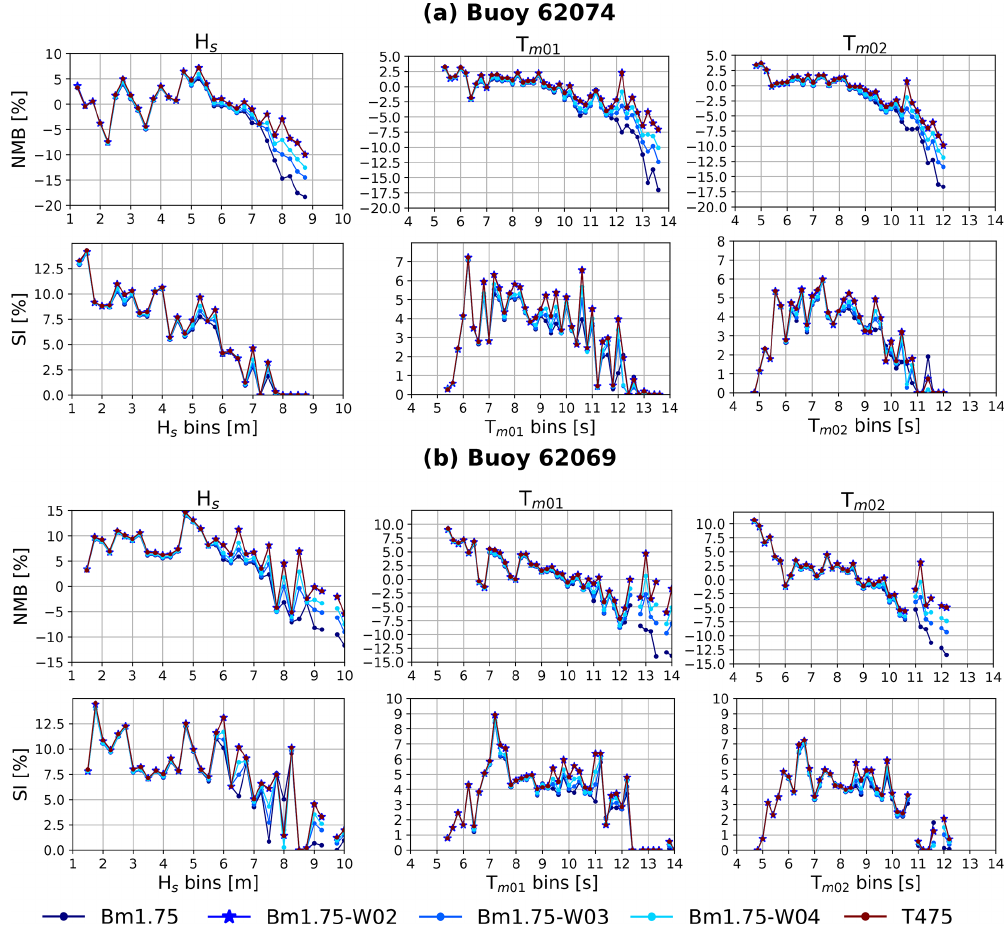
Figure 6. Bias (NMB) and scatter index (SI) for tests leading to T475 (Table 2). Results for January 2014. In (a) and (b) modeled results are compared with buoys 62074 and 62069, respectively. H s bin size is 0.25m; periods bin size is 0.2s. T m01 and T m02 are computed integrating the spectra in the frequency range